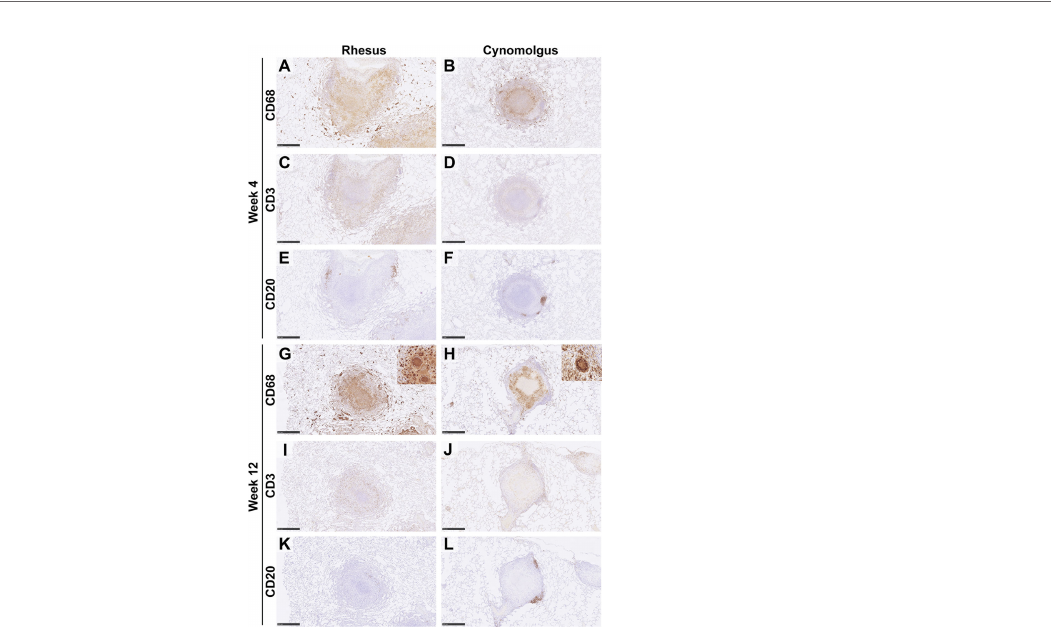
FIGURE 3 | Representative images of immune cell staining (brown) in category 5 granulomas at 4wpc and 12wpc in rhesus and cynomolgus macaques. IHC. Images show the distribution of immune cells in a category 5 granuloma from RM and CM. At 4wpc, CD68+ cells were predominately con fi ned to the centre of the granuloma and form a cuff of cells separating the lymphocyte cuff from necrosis (A, B) . CD3+ T cells were found scattered in a lymphocyte cuff on the periphery of the granuloma (C, D) . CD20+ B cells are predominately found in follicle like structures on the periphery of the granuloma (E, F) . At 12wpc, location of cells were similar to 4wpc [CD68+ (G, H) ; CD3+, (I, J) ], however CD20+ B cells in RM do not always form follicle like structures (K, L) . Bars in micrographs (A, C, E, G – L) = 500µm, (B, D, F) = 1000µm. Representative images from 2 slides per animal at each time point (week 4 & 12 = 4 RM & 4 CM). See Supplementary Material for images of all categories at each time point in both RM &